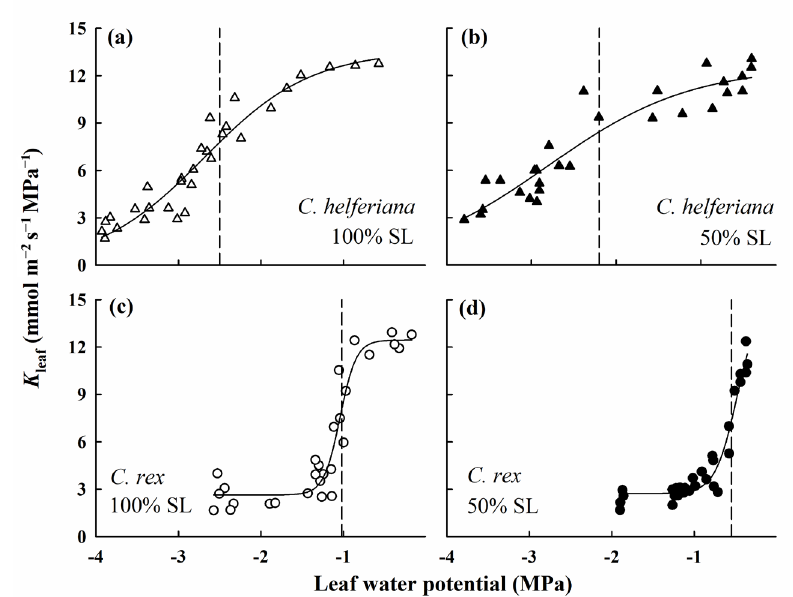
Figure 5. Changes of leaf hydraulic conductance ( K leaf ) with the decrease in leaf water potentials (Ψ L ) during the water withholding treatment in seedlings of C. helferiana ( a,b ) and C. rex ( c,d ) grown under 100% and 50% sunlight conditions. A sigmoid function was fitted to the data in each panel (y = a⁄(1 + exp ( − (x − x 0 )⁄b ))). The vertical dashed lines mark water potentials at 50% loss of leaf hydraulic conductance (P50 leaf ).